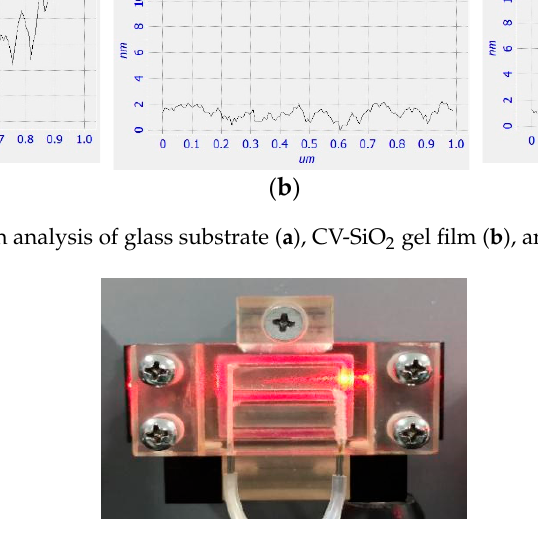
Figure 3. Photograph of a scattering-induced streak along the traveling path of the 633 nm laser in the CV-SiO 2 gel film.